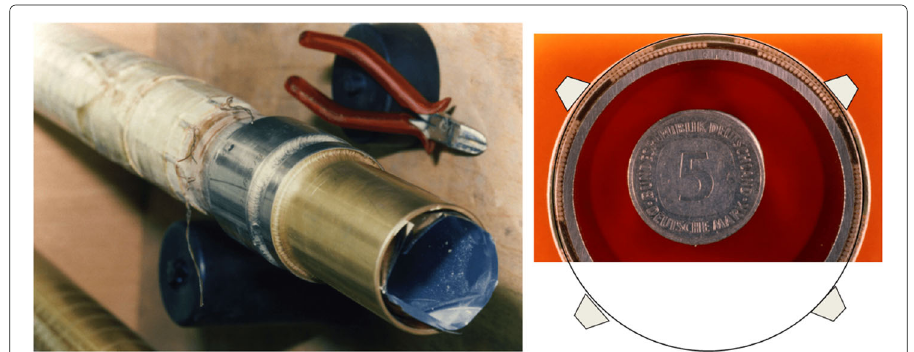
Fig. 6 The beam tube of the HERA dipole. Indicated are (right) the Vespel spacers which keep the pipe centered in the coil and force the pipe to follow the deformation of the yoke